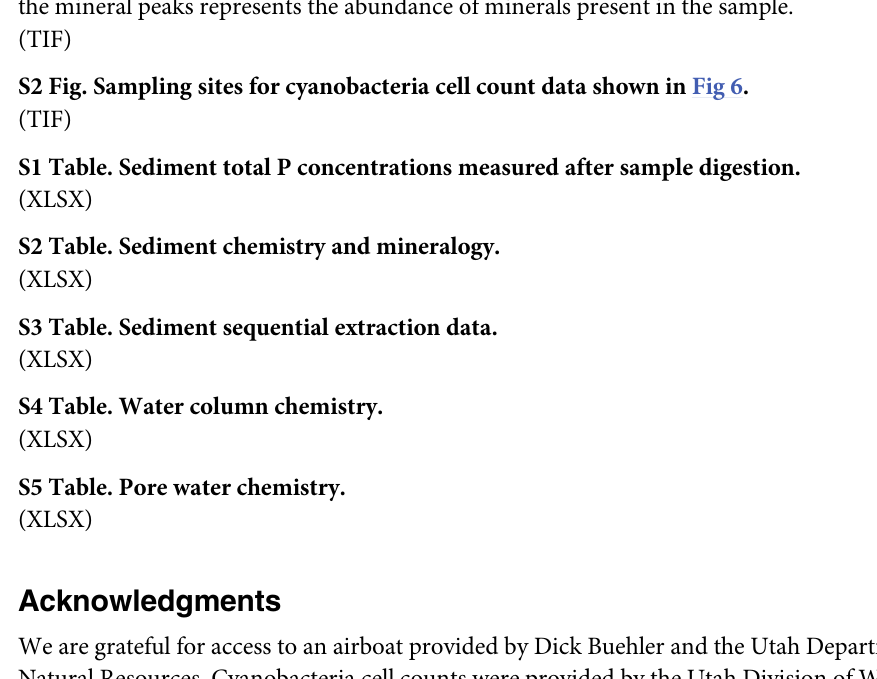
S2 Fig. Sampling sites for cyanobacteria cell count data shown in Fig 6. S1 Table. Sediment total P concentrations measured after sample digestion. S2 Table. Sediment chemistry and mineralogy. S3 Table. Sediment sequential extraction data. S4 Table. Water column chemistry. S5 Table. Pore water